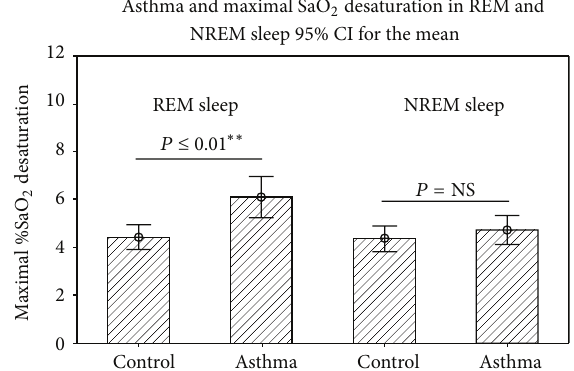
Figure 1: Maximal SaO 2 desaturation in REM and NREM sleep by asthma status in children. Data are presented as mean and 95% confidence interval (CI). REM: rapid eye movement; NREM: nonrapid eye movement; SaO 2 : Oxygen saturation; 𝑃 values are obtained by two-sample student 𝑡